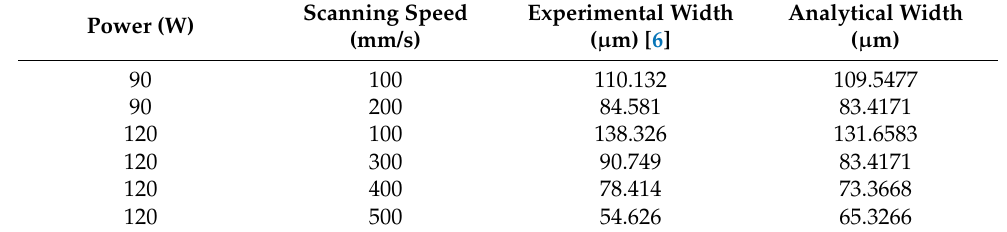
Table 4. Comparison of molten pool width between predictions and experimental results.